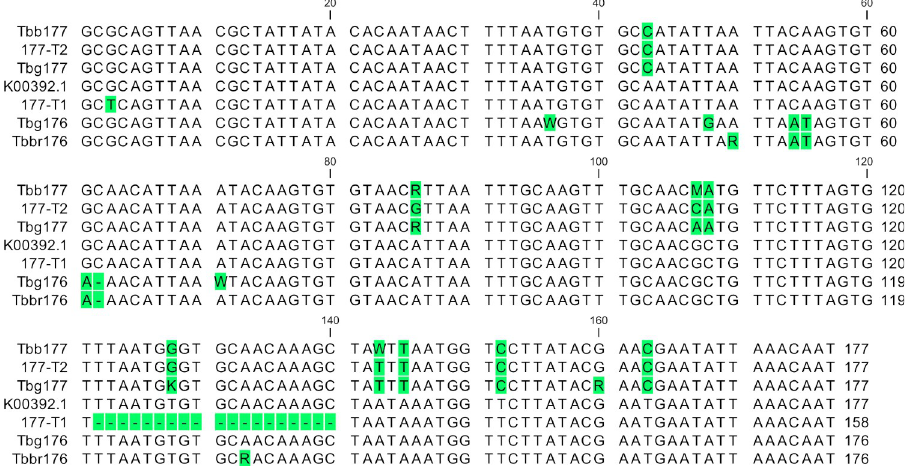
Fig 1. Novel TBR groups identified by BLAST. Alignment of the TBR sequence [K00392.1], both TBR variants, 177-T1 and 177-T2, and the 80% consensus sequences derived from each of the four TBR sequence sets. Polymorphisms in comparison to K00392.1 are indicated in